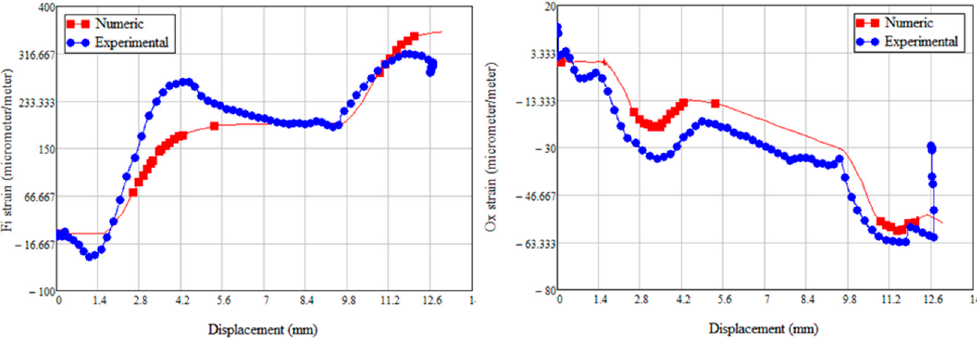
Figure 12. Specific deformations on the axial direction and the circumference depending on the displacement of the cover for the case of oil mounting, compared to the numerical simulations.